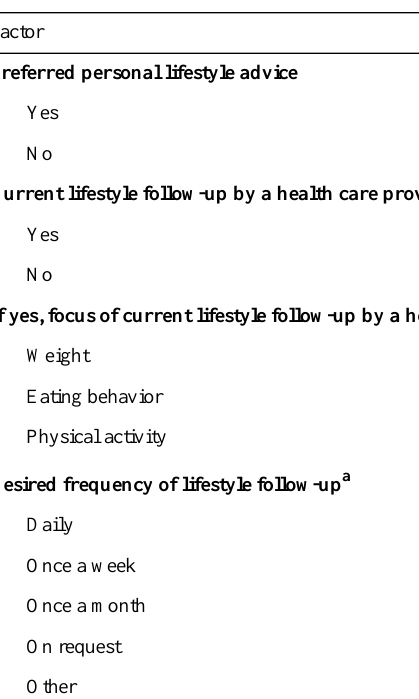
Table 4. Results from the survey of pregnant women